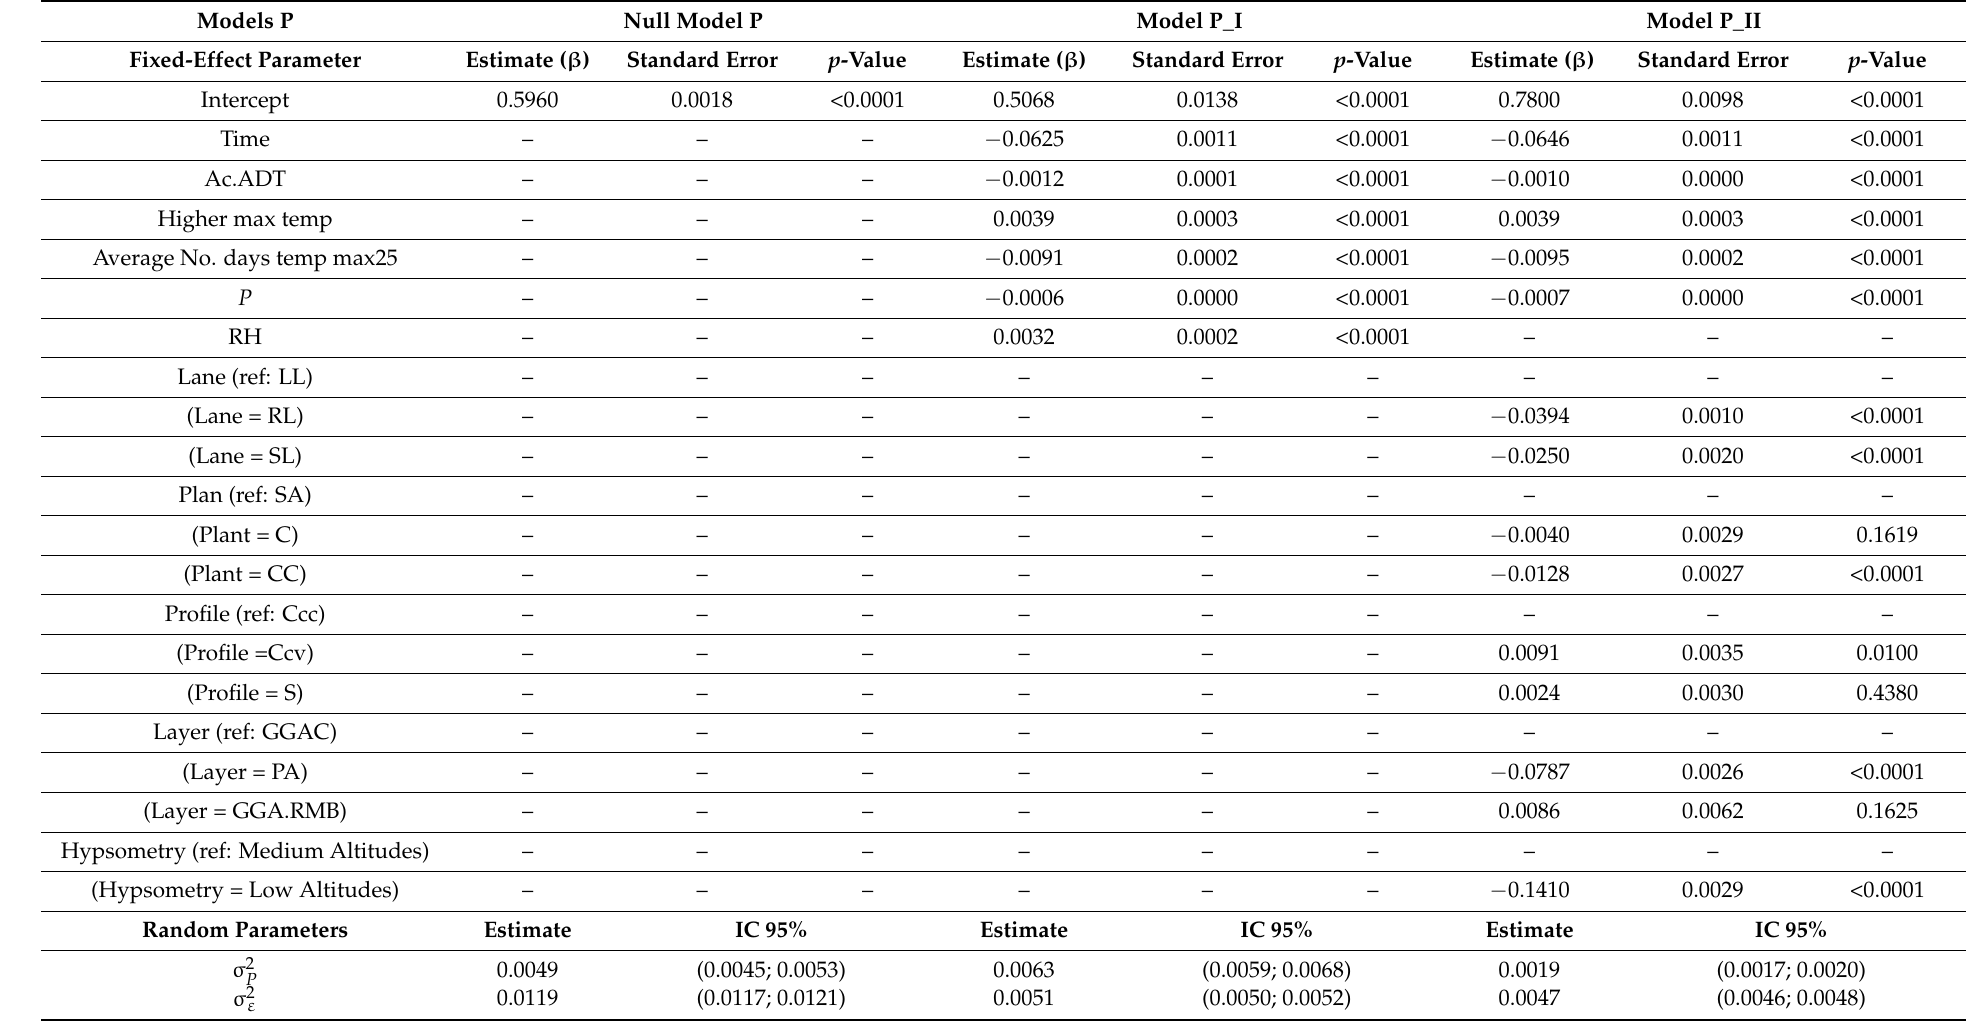
Table 8. Results of the friction models P for the two-level